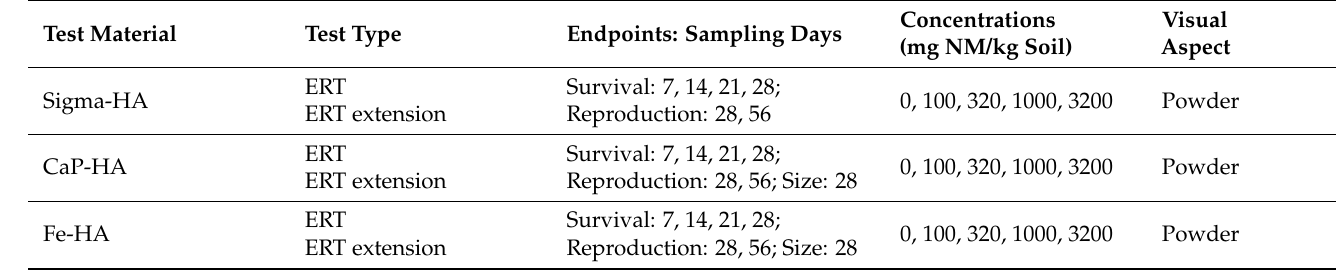
Table 1. The summary of the test type, endpoints, and tested concentrations for each test mate- rial: commercial hydroxyapatite (Sigma-HA), calcium hydroxyapatite (CaP-HA),